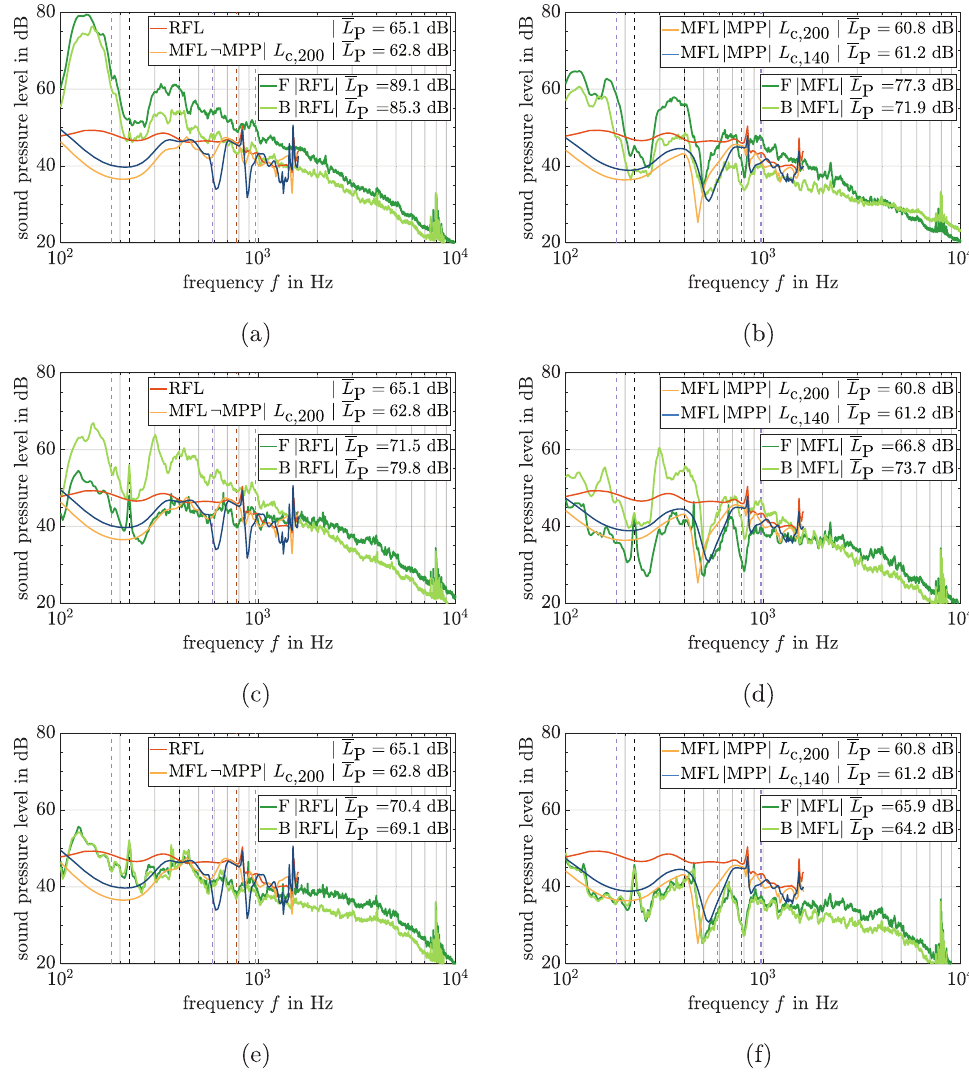
Figure 13. Measured and simulated sound emission spectra of the RFL-MFL con fi guration; (a, c, e) show simulated cases without MPP and in (b, d, f) the MPP is added. (a) RFL emission spectrum at 0.8 m 3 s (cid:4) 1 . (b) MFL emission spectrum at 0.8 m 3 s (cid:4) 1 . (c) RFL emission spectrum at 1.4 m 3 s (cid:4) 1 . (d) MFL emission spectrum at 1.4 m 3 s (cid:4) 1 . (e) RFL emission spectrum at 1.9 m 3 s (cid:4) 1 . (f) MFL emission spectrum at 1.9 m 3 s (cid:4) 1